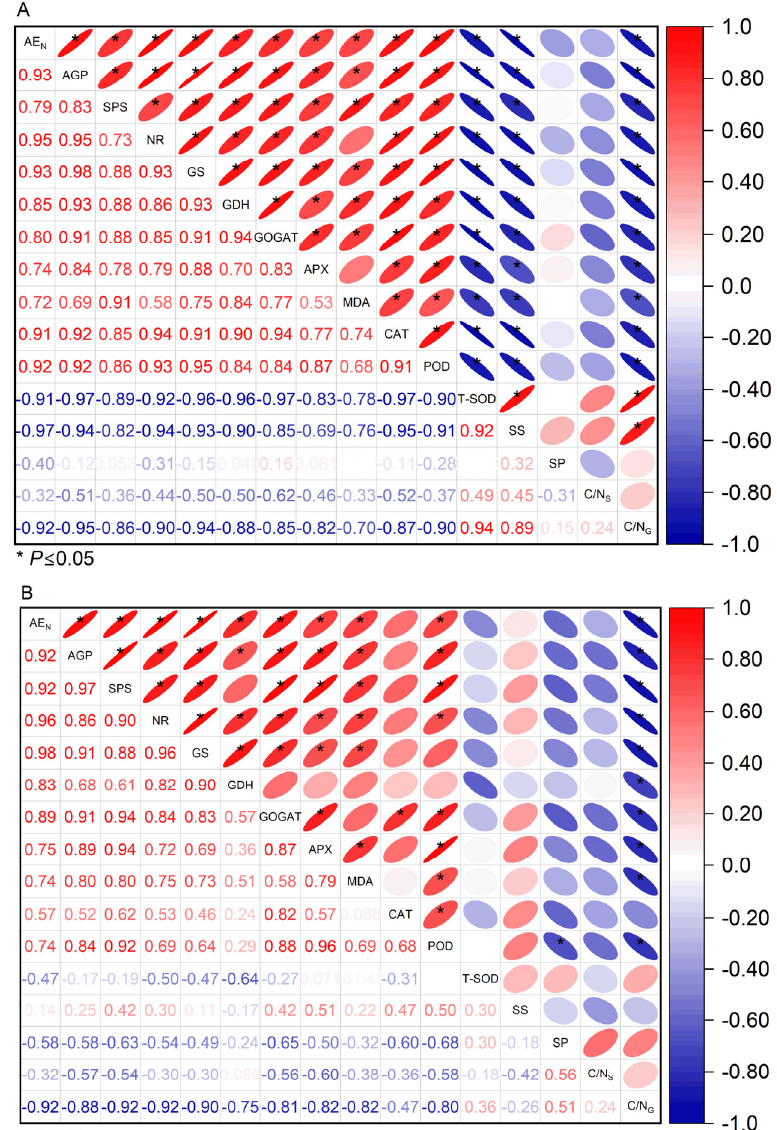
Figure 10. Relationship between the agronomic nitrogen use efficiency (AE N ) and adenosine diphos ‐ phate glucose pyrophosphorylase (AGP), sucrose phosphate synthase (SPS), nitrate reductase (NR), glutamine synthetase (GS), glutamate dehydrogenase (GDH), glutamate synthase (GOGAT), total ascorbate peroxidase (APX), MDA, catalase (CAT), peroxidase (POD), total superoxide dismutase (T ‐ SOD), Soluble sugars (SS), soluble proteins (SP), C/N S and C/N G at HD ( A ) and 15DAH ( B ). * denote statistical significance at the 0.05 levels.